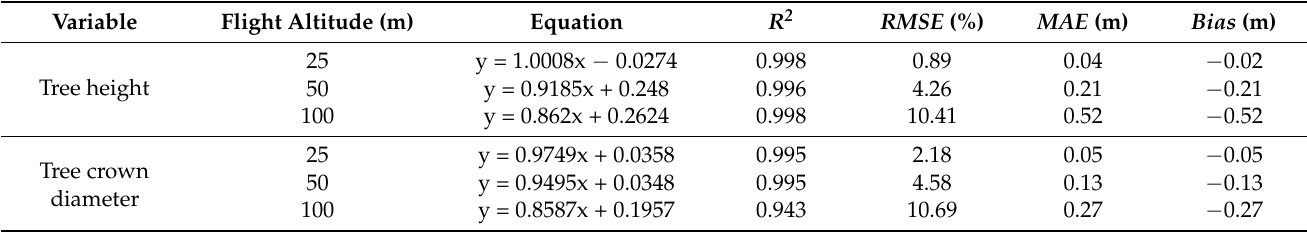
Table 4. The results of the fitted linear regression